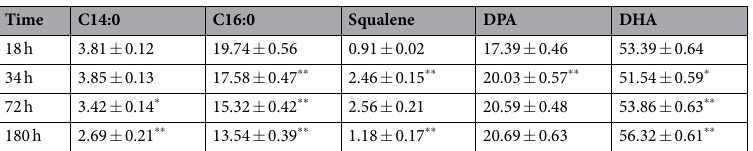
Table 1. Fatty acid composition of Schizochytrium sp.HX-308 during fermentation. Each datum is the mean ± S.D. of three independent experiments replicates. The statistical significance between two adjacent times was presented by t-test, * P < 0.05, ** P <